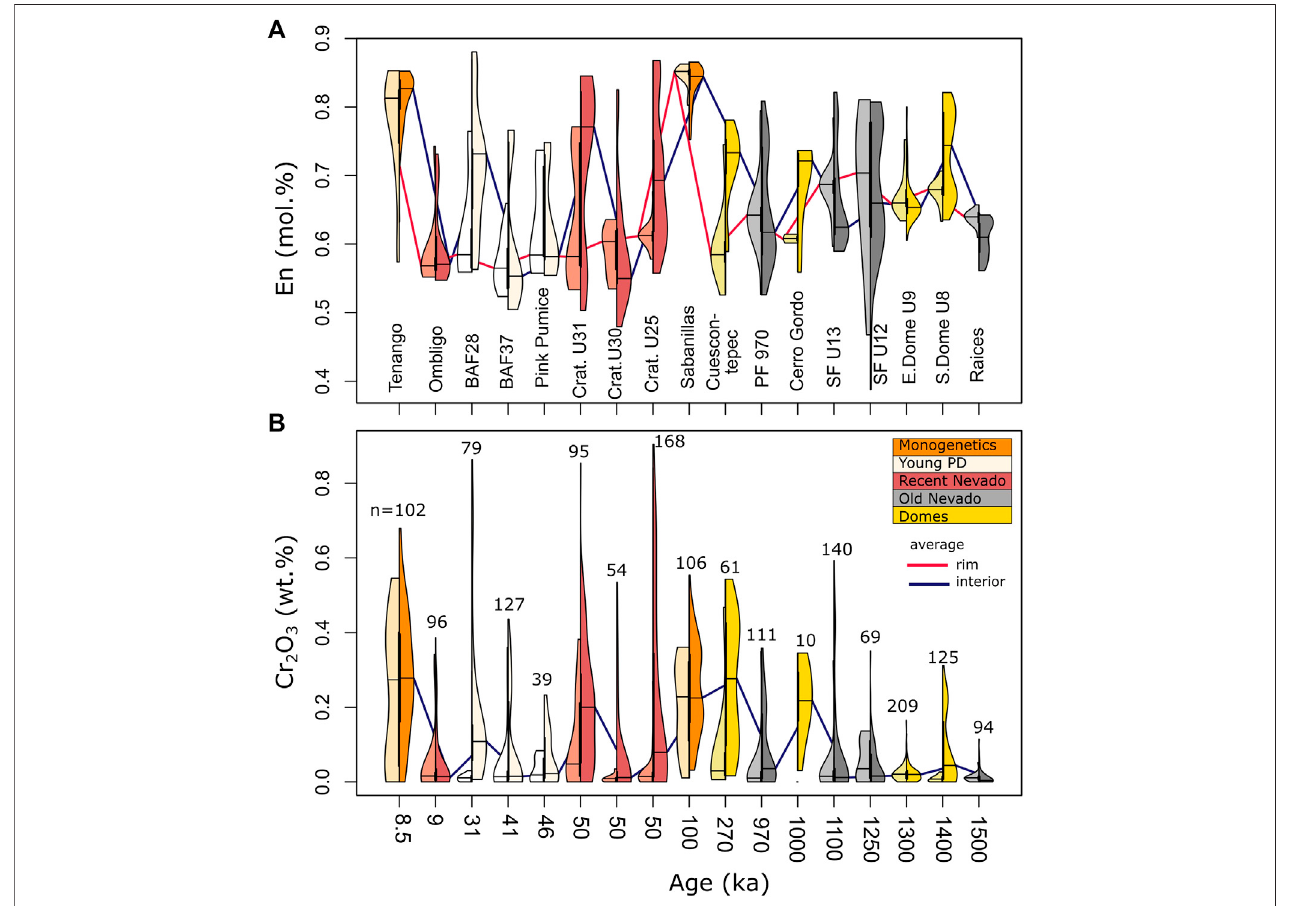
FIGURE 13 | Variation of orthopyroxene compositions with time. The color coding re fl ects the eruptive groups: Monogenetics (orange), Young PD (beige), Recent Nevado (red), Old Nevado (gray), Domes (gold). (A) Temporal variation of En (mol%) distributions for various eruptions (labels). (B) Variation in Cr 2 O 3 content (wt%) with time with number of analysis ( n ) indicated above the